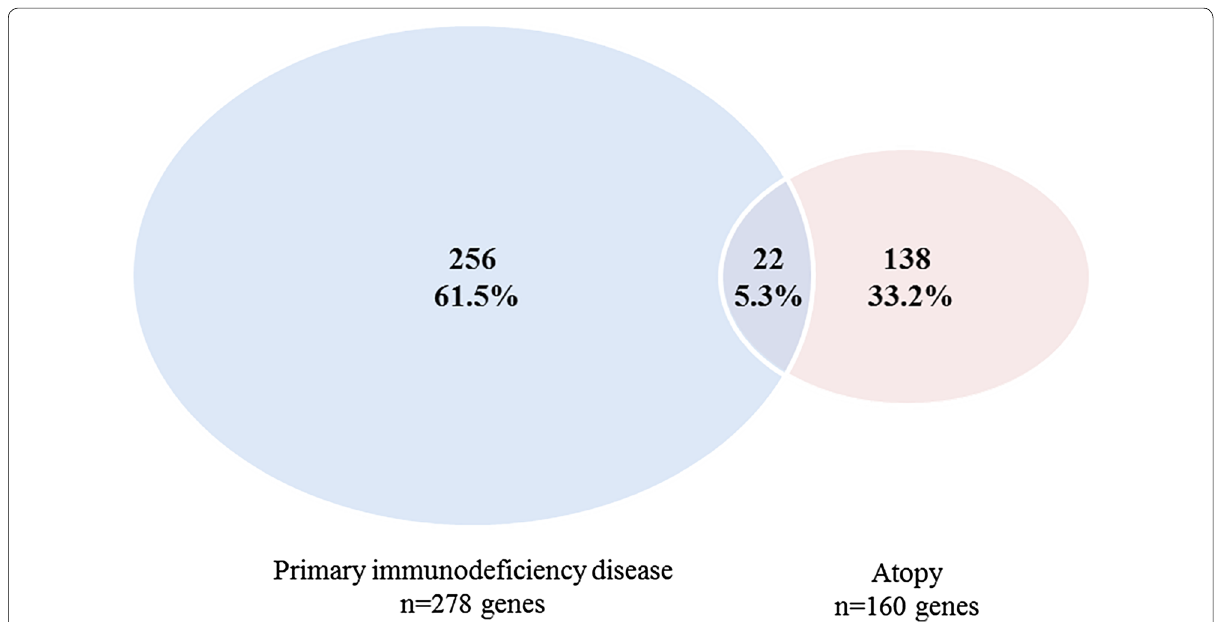
Fig. 1 Venn diagram illustrating the overlap of the disease causing genes of monogenic primary immunodeficiency diseases and the atopy-related genes identified in the Human Gene Mutation